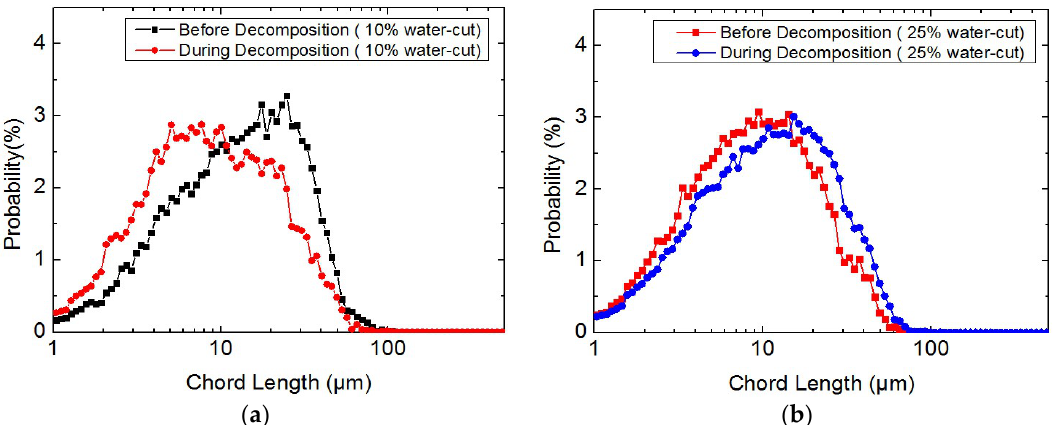
Figure 11. Influence of water-cut on chord length distribution during hydrate dissociation ( a , b ). ( a ) Influence of water-cut on chord length distribution (10% water-cut); ( b ) Influence of water-cut on chord length distribution (25% water-cut).